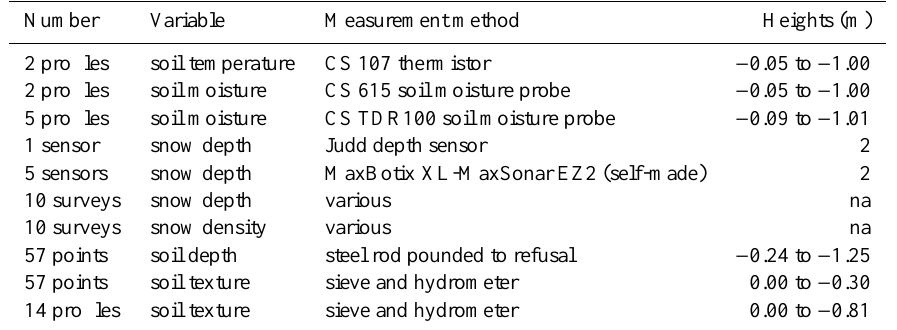
Table 2. Distributed watershed data, number of sensors, type of instruments, and instrument heights from the Treeline experimental catch- ment for